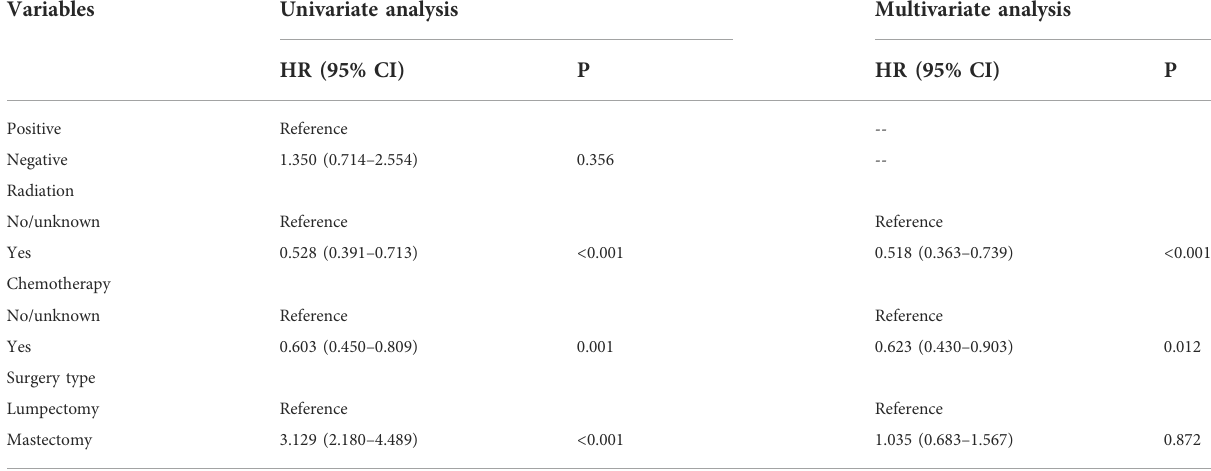
fi rst nomogram for predicting the postoperative survival